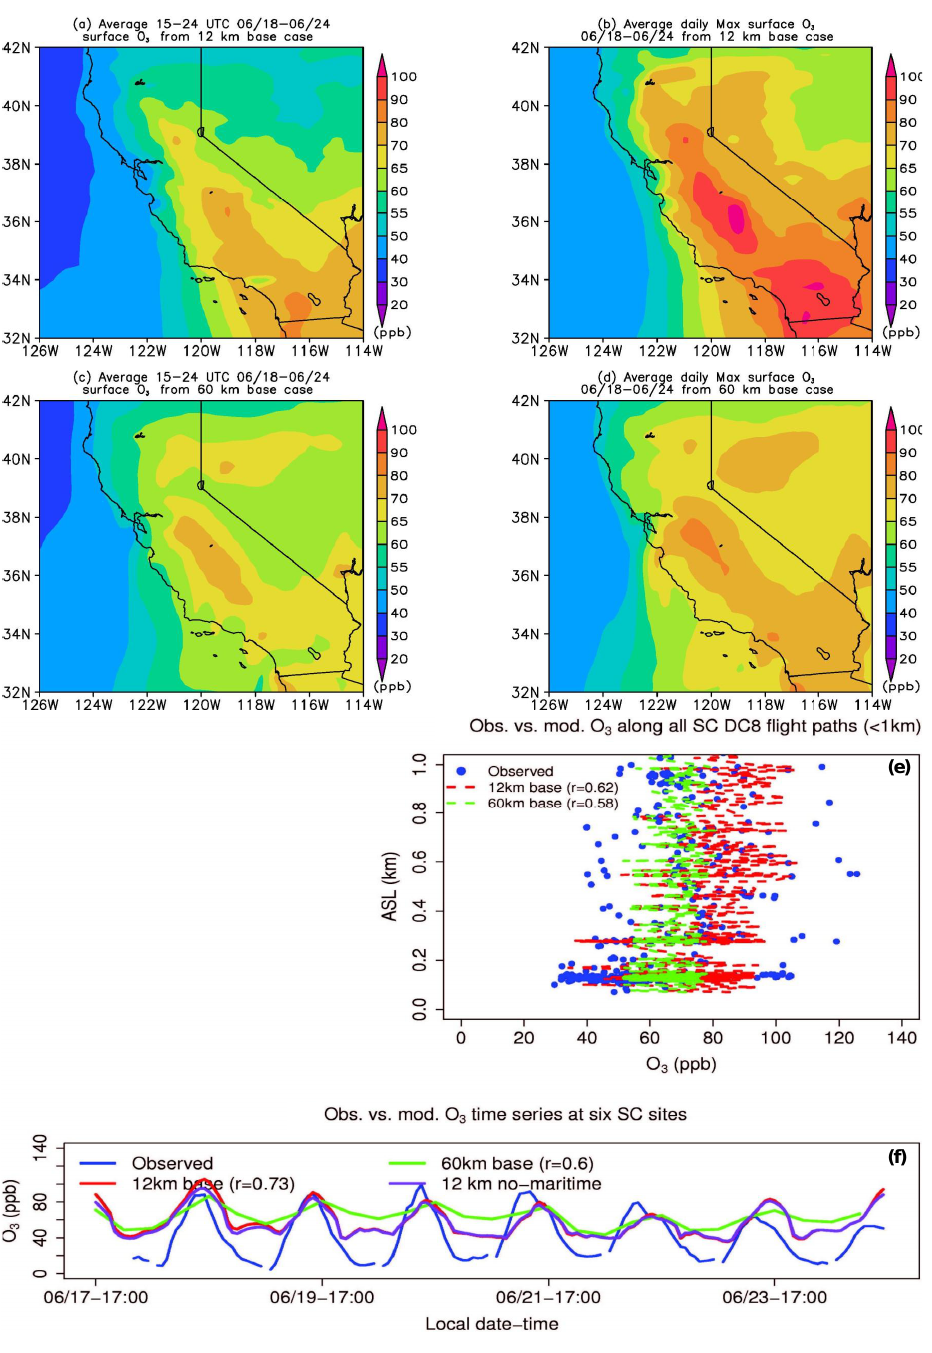
Figure 3 (cont.) (e) Observed and modeled O 3 vertical profiles along all SC flight paths below 1 km; (f) Observed and modeled (60 km base, 12km base and no-maritime emissions cases) O 3 time series at six SC surface sites.